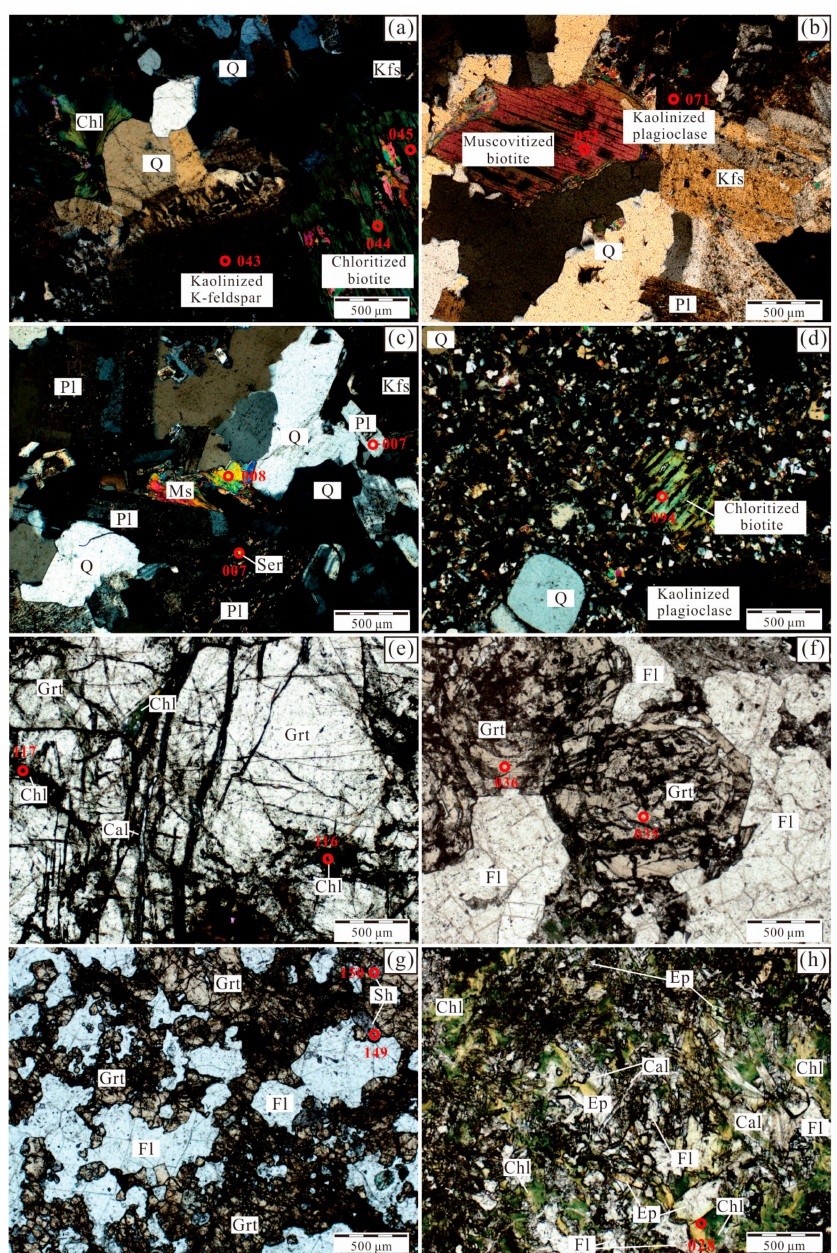
Figure 4. Photomicrographs of fresh and altered minerals in granites and skarns from the Shizhuyuan W-polymetallic deposit. ( a ) Granite 1; ( b ) Granite 2; ( c ) Granite 3; ( d ) Granite 4; ( e ) Garnet skarn; ( f ), ( g ) Fluorite-garnet skarn; ( h ) Epidote-fluorite-chlorite skarn. Q: quartz; Bi: biotite; Kfs: K-feldspar; Pl: plagioclase; Ms: muscovite; Ser: sericite; Grt: garnet; Chl: chlorite; Cal: calcite; Fl: fluorite; Ep: epidote; Sh: scheelite. The circles are LA-ICP-MS analytical spots with their numbers corresponding to those listed in Table